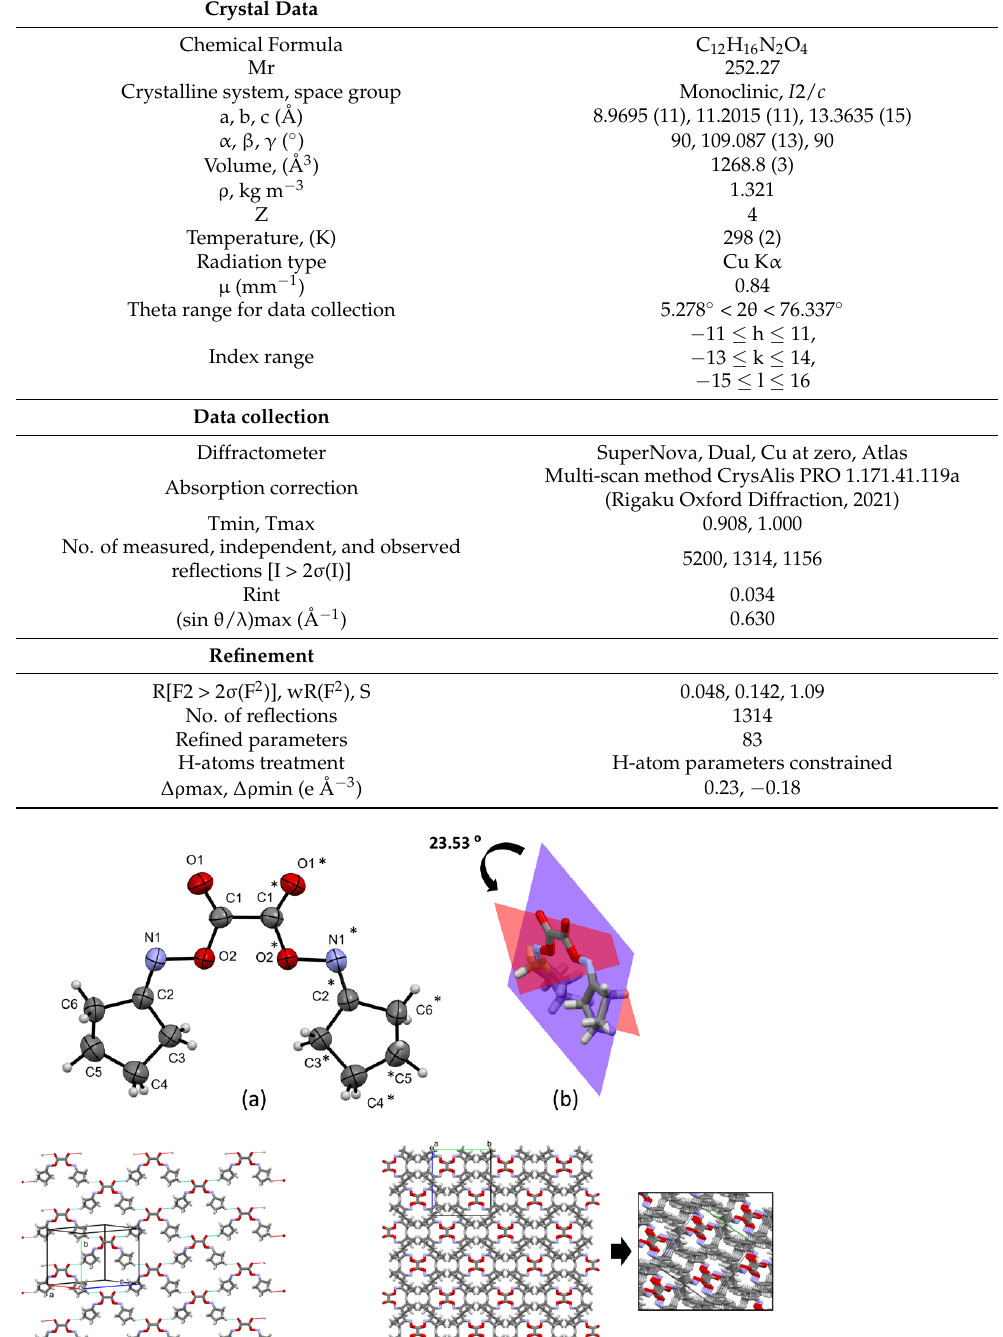
Table 2. Crystallographic data of cyclopentanone dioxime oxalate.